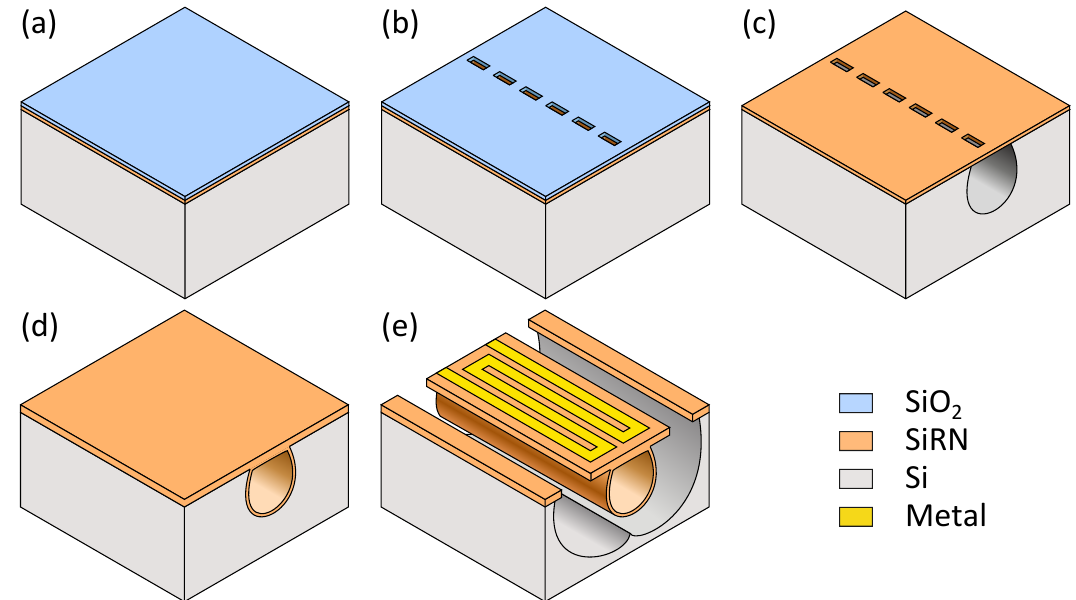
Figure 9. Fabrication process for Surface Channel Technology . ( a ) silicon wafer with 500 nm SiRN and 500 nm SiO 2 ; ( b ) patterning of slit openings; ( c ) removal of SiO 2 hard mask and forming of the surface channel; ( d ) closing of the channel; ( e ) patterning of metal and release of the